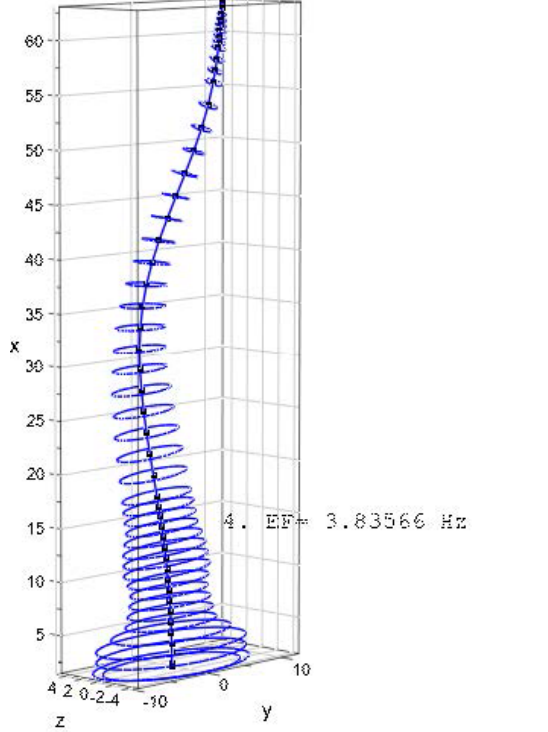
Figure 8. Mixed flap/edgewise